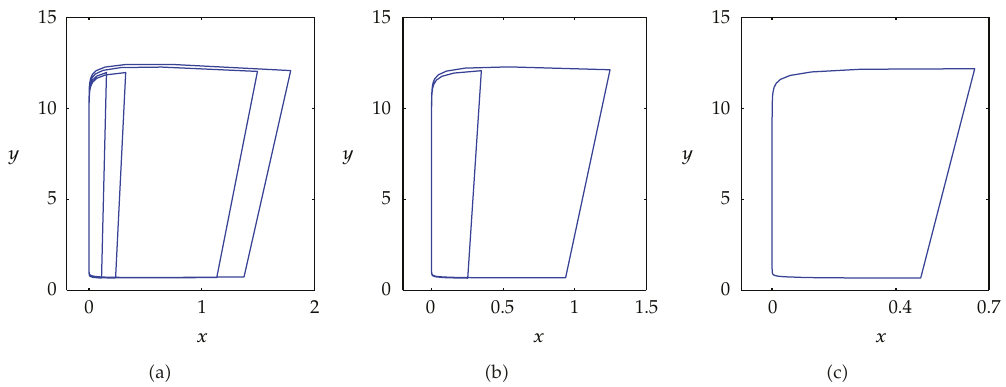
Figure 8: Period-halving bifurcation from 4 T -periodic solutions to cycles of (cid:3) 1.3 (cid:4) . (cid:3) a (cid:4) Phase portrait of a 4 T -period solution for q (cid:6) 11 . 3. (cid:3) b (cid:4) Phase portrait of a 2 T -period solution for q (cid:6) 11 . 4. (cid:3) c (cid:4) Phase portrait of a T -period solution for q (cid:6) 11 .